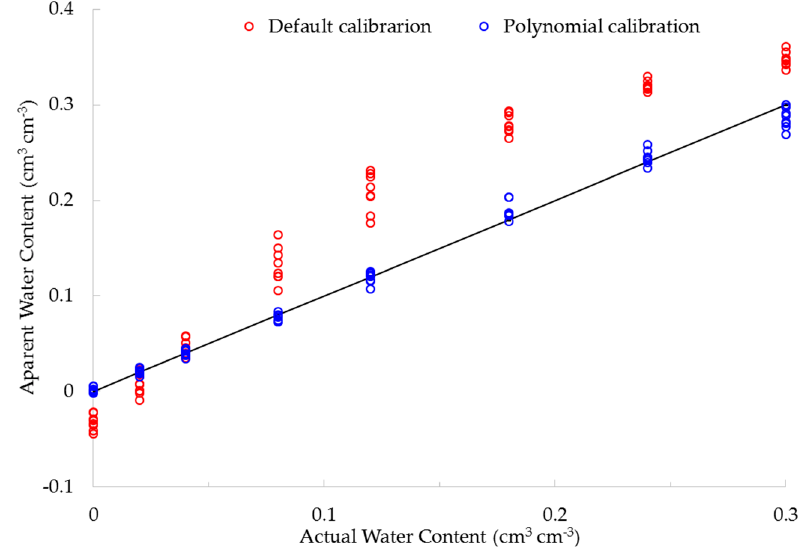
Figure 3. Scatter plot of the actual water content vs. apparent water content predicted using the default calibration equation.